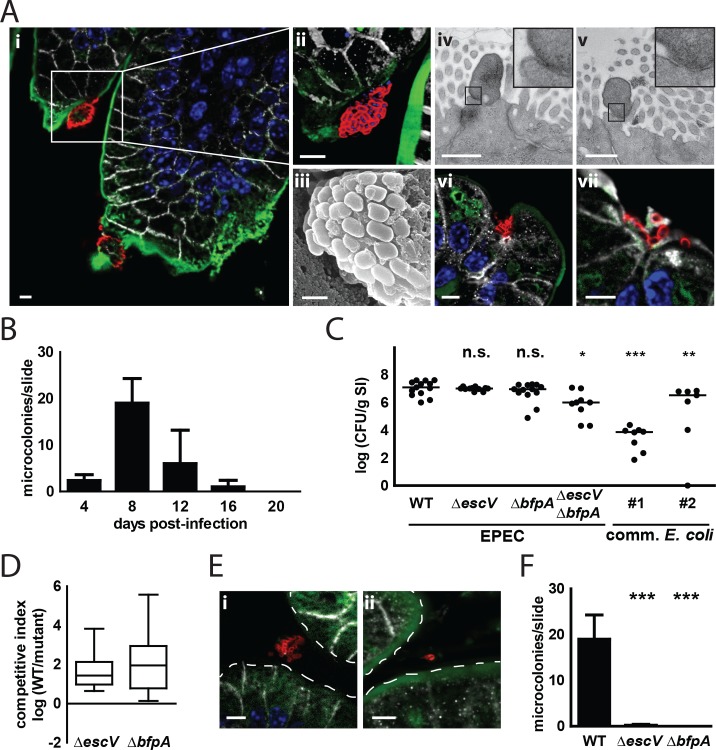
T3SS- and BFP-dependent generation of epithelial microcolonies in vivo.
(A) Immunostaining and electron microscopy of small intestinal tissue sections collected 8 days p.i. from mice orally infected on the day of birth with WT EPEC. (Ai;vi-vii) 2d representation of microcolonies attached to the small intestinal epithelium. (Aii) enlarged 3d representation of the insert marked in (Ai) (EPEC, red; E-cadherin, white; wheat germ agglutinin (mucus), green; DAPI, blue, bar = 5μm). (Aiii) SEM of EPEC forming a microcolony (bar = 1 μm). (Aiv-v) TEM of EPEC attached to the epithelial plasma membrane (bar = 0.5 μm). (B) Number of microcolonies per small intestinal tissue section at defined time points p.i. (n = 9 from 3 mice per time point, mean ± SD). (C) 1-day-old mice were orally exposed to WT EPEC, escV or bfpA single mutants, a escV/bfpA double mutant or two commensal E. coli strains (#1, a murine commensal E. coli isolate; #2, E. coli Nissle). Small intestinal tissues were collected 4 days p.i., homogenized and plated on LB agar plates supplemented with streptomycin (WT), kanamycin (escV, bfpA, escV/bfpA mutants) or ampicillin (commensal E. coli strains) (n = 7–13 from at least 2 litters; median). (D) 1-day-old mice were orally co-infected with WT EPEC and either escV or bfpA mutants at a 1:1 ratio (total: 1–2×105 CFU). Total small intestinal tissues were collected 8 days p.i., homogenized and plated on different LB agar plates supplemented with the appropriate antibiotic to discriminate WT EPEC from escV or bfpA mutants (n = 15–24 from at least 2 litters; data are represented in box and whisker plot format). (E) Immunostaining of small intestinal tissue sections collected 8 days p.i. from mice orally infected at birth with escV
(i) or bfpA mutants (ii) (EPEC, red; E-cadherin, white; wheat germ agglutinin (mucus), green; DAPI, blue; bar = 5μm). (F) Number of microcolonies observed per small intestinal tissue section in animals infected with WT EPEC or with escV or bfpA mutants at 8 days p.i. (n = 9 from 3 mice per time point, mean ± SD). ANOVA with Dunnett’s post-test (C and F). ns, p>0.05; *, p<0.05; **, p<0.01; ***, p<0.001.